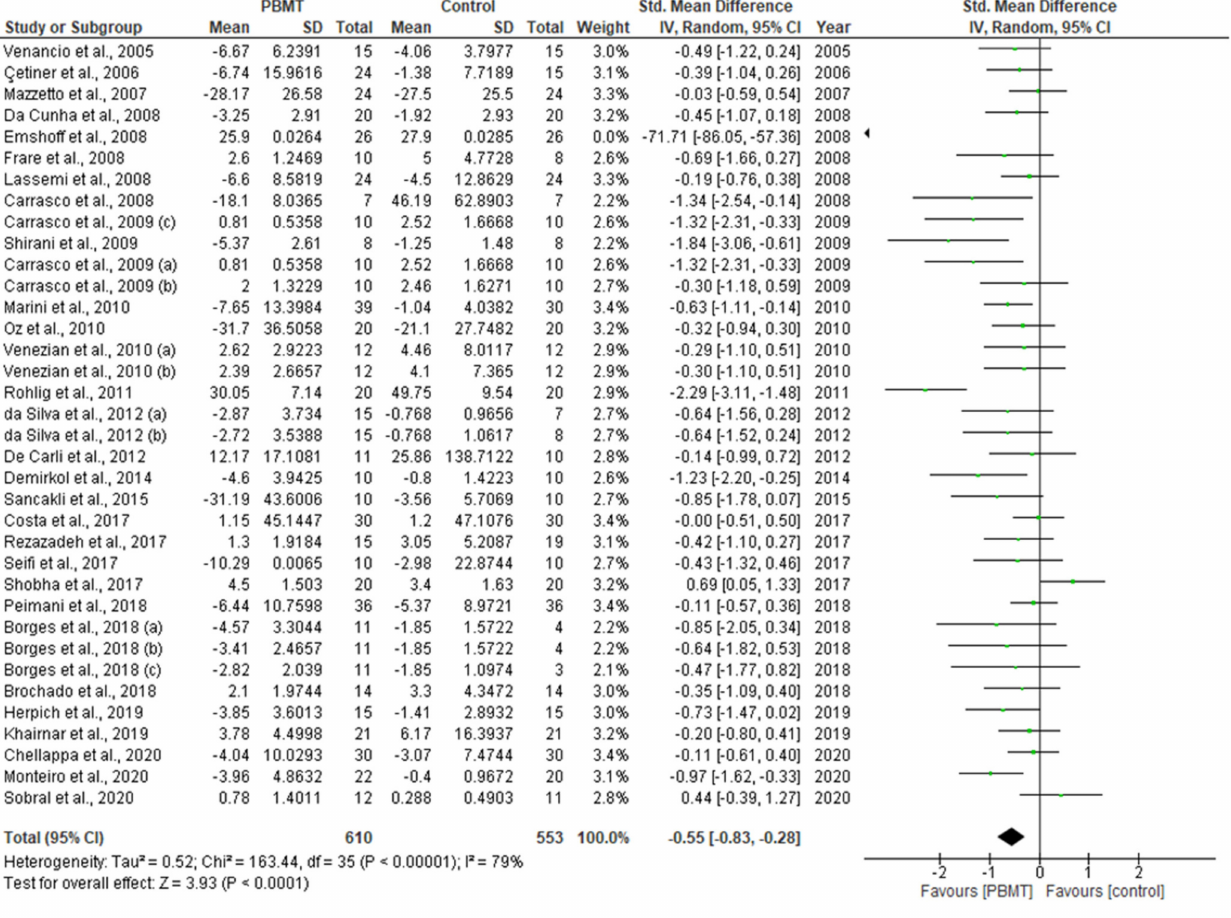
Figure 5. Forest plot for primary outcome pain assessment (VAS score) from baseline up to the final follow-up